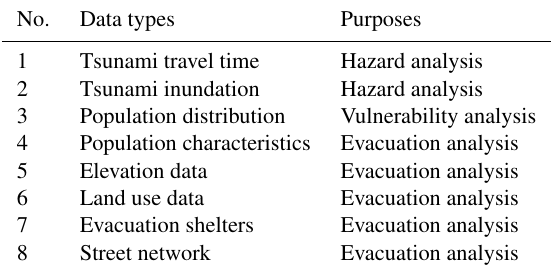
Table 1. Data required for the decision support system.